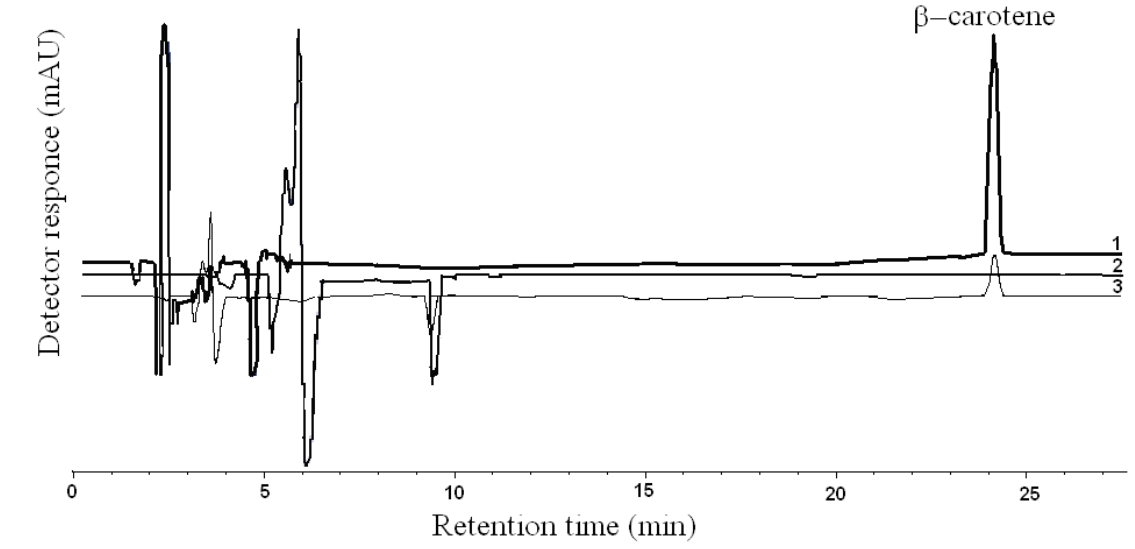
Figure 2. Isocratic elution was performed with methanol-acetonitrile-tetrahydrofuran (65:30:5, v/v/v) as mobile phase at a flow rate of 1.5 mL min -1 , 40 0 C. Inertsil ODS3 reversed phase column (250×4.6 mm 5 µm) was employed. DAD was adjusted at 450 nm.